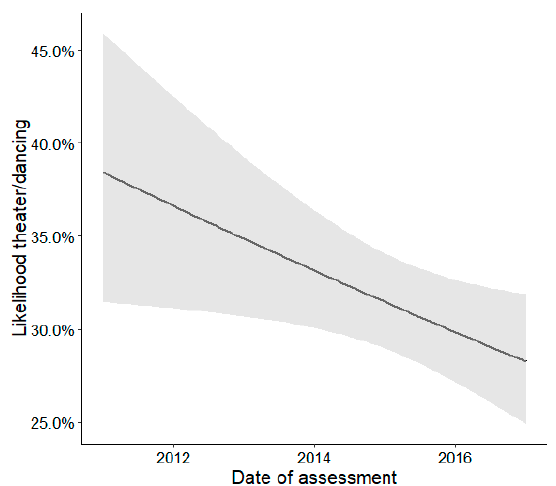
Figure 3. Effects plot illustrating the estimated changes over time (2011–2017) described as association between theater/dancing and date of assessment. The shaded area indicates the 95% confidence intervals of the estimated effect.